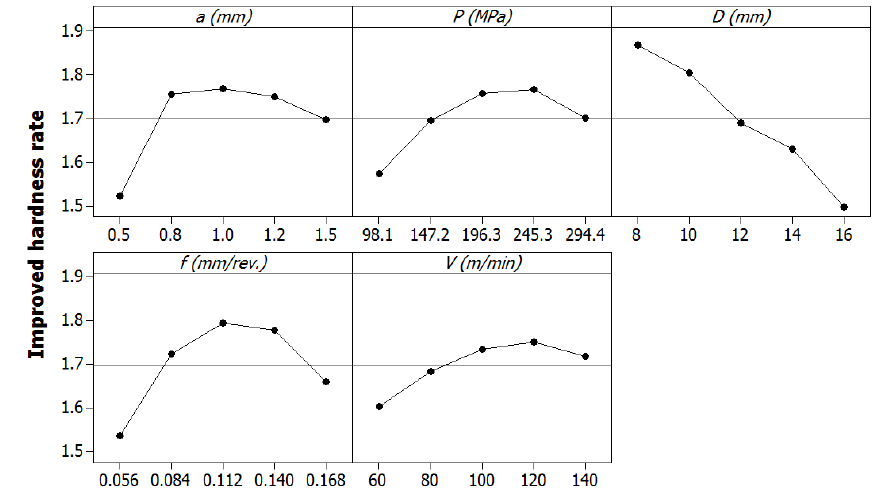
Figure 10. The main effects of machining parameters on the improved hardness ratio.